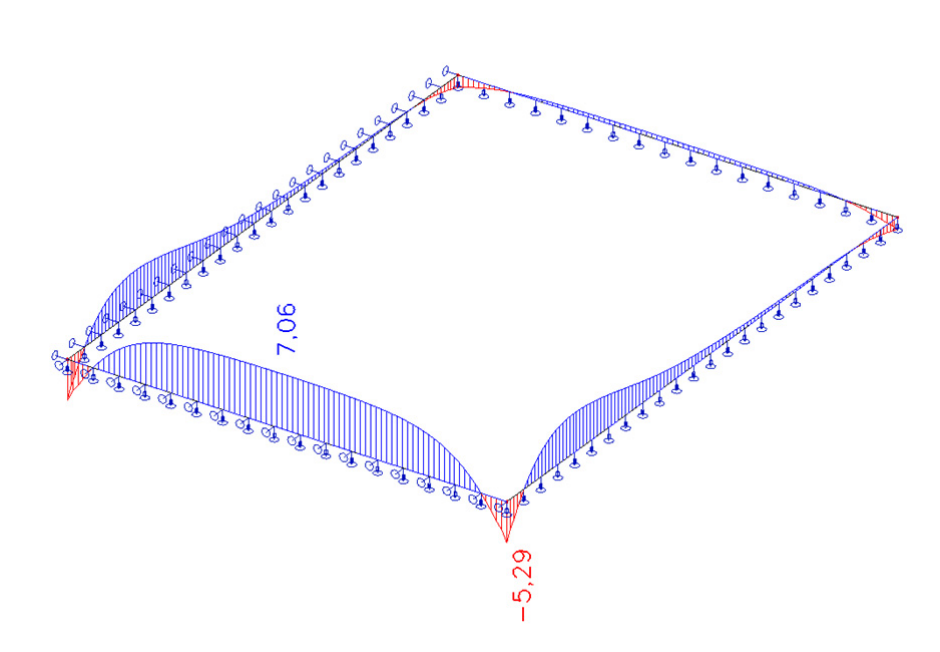
Fig. 7 Reaction forces of end wall in kN/m (case of broken sheet)